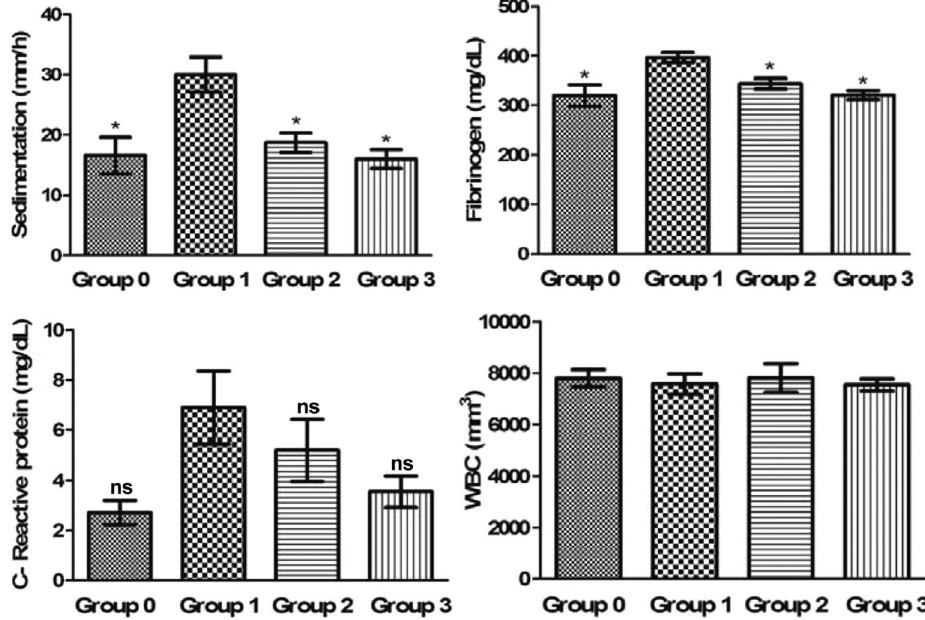
Figure 1. Comparison of the groups in terms of mean measurements of the acute-phase reactants. Blood samples were collected every 6 months during the 2 years following diagnosis of familial Mediterranean fever. Data are reported as means±SE. Group 0, no mutation; group 1, homozygous; group 2, compound homozygous; group 3, heterozygous. WBC = white blood cell. One-way analysis of variance and the post hoc Tukey test were used for statistical analyses. *P # 0.05, groups 0, 2, and 3 compared to group 1; ns P . 0.05, not significant in general, second, third and fourth